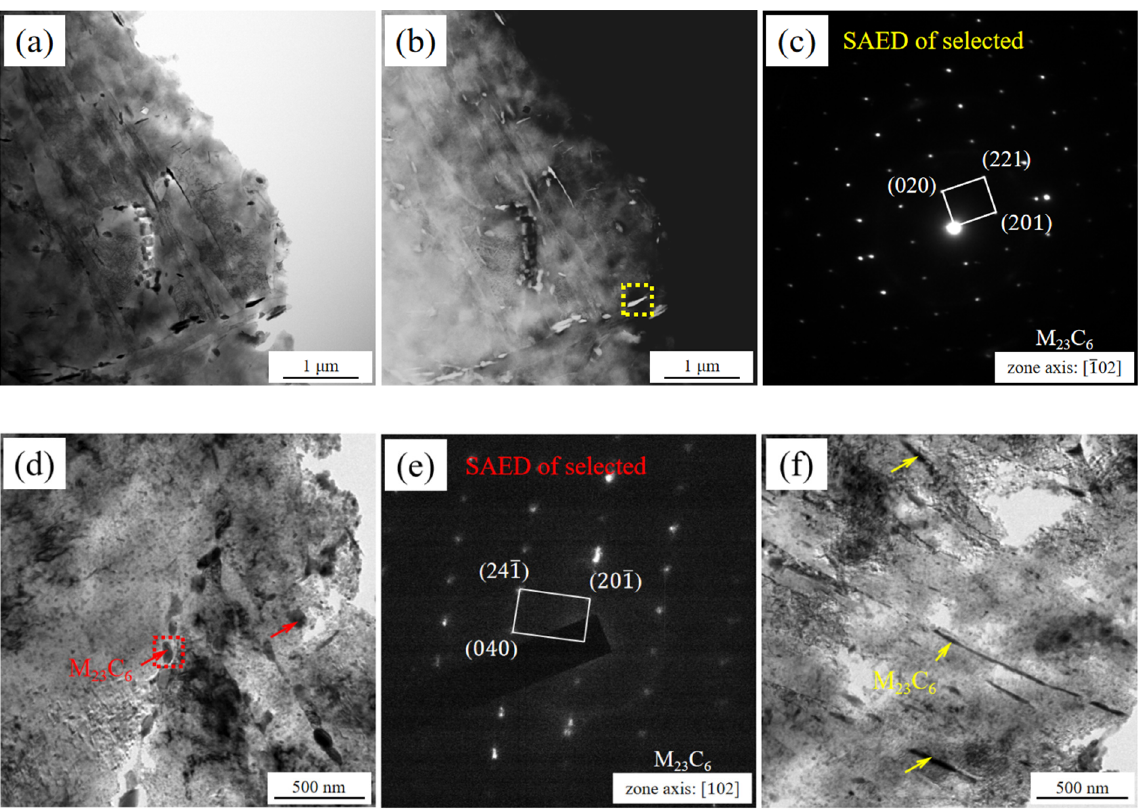
Figure 7. ( a – c ) STEM images of sample T500 and corresponding indexed precipitates SAED pattern. ( d , e ) Bright-field TEM micrographs and SAED pattern of M 23 C 6 in sample T460. ( f ) Bright-field TEM micrographs of M 23 C 6 in sample T580.